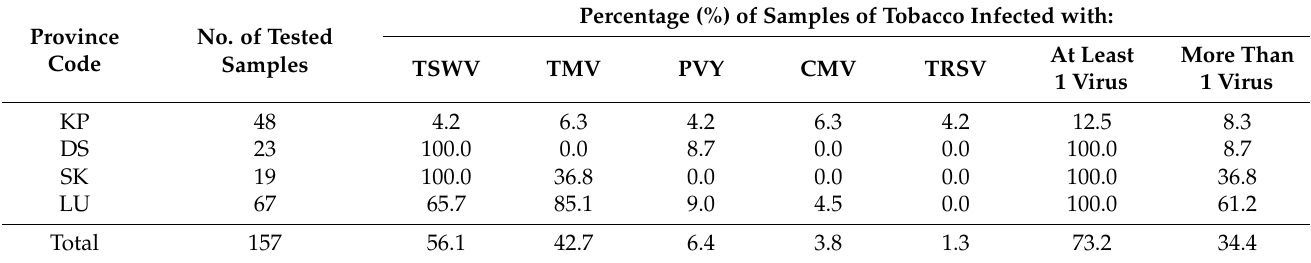
Table 3. Results of DAS-ELISA detection of five viruses in the samples of tobacco collected in four provinces in Poland.